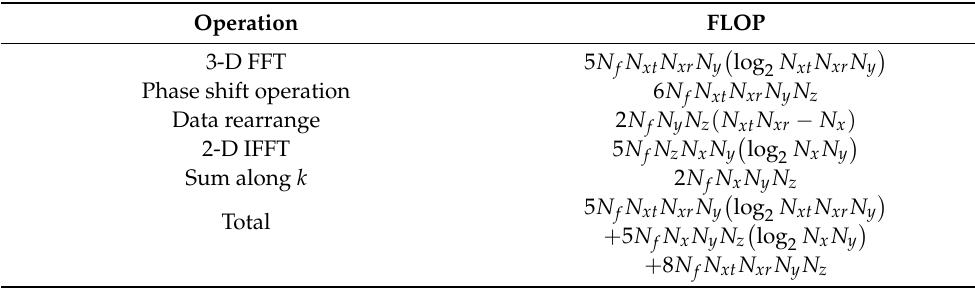
Table 3. Detailed Cost of the MIMO-SAR PSM